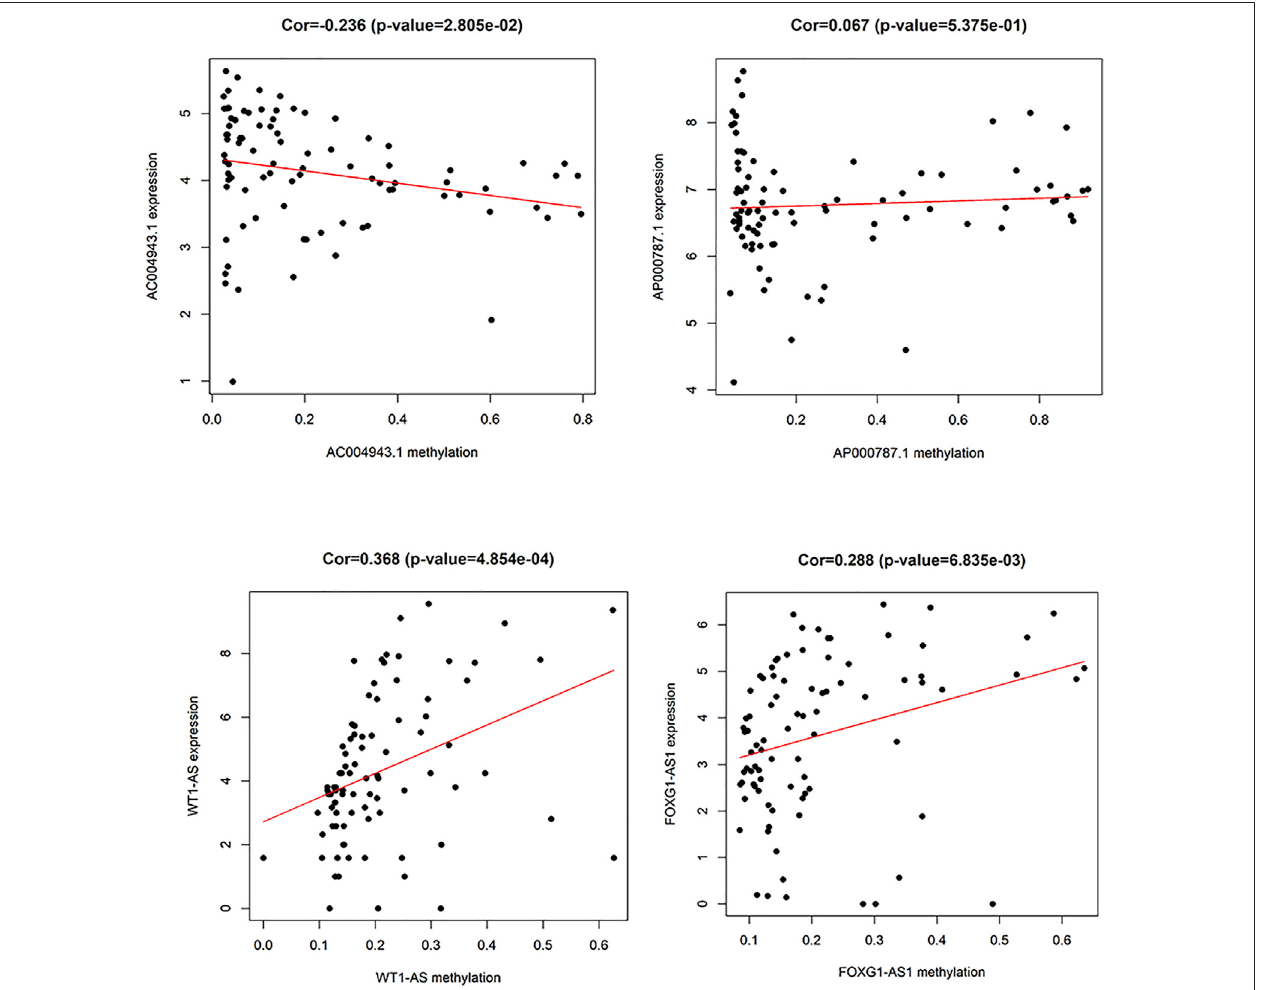
FIGURE 3 | Relationship of the expression level and DNA methylation level of immune-related lncRNAs.